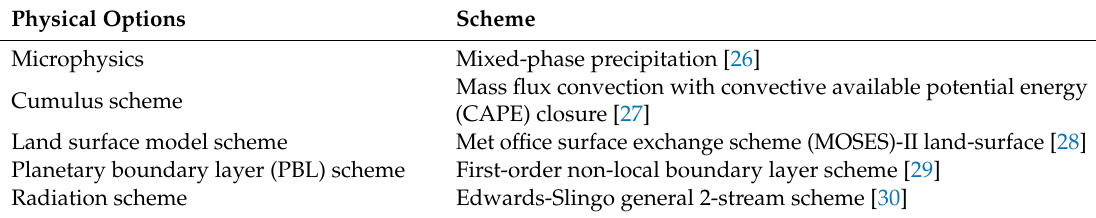
Table 2. Physical options of unified model (UM)-based numerical weather prediction (NWP) system used in KMA.